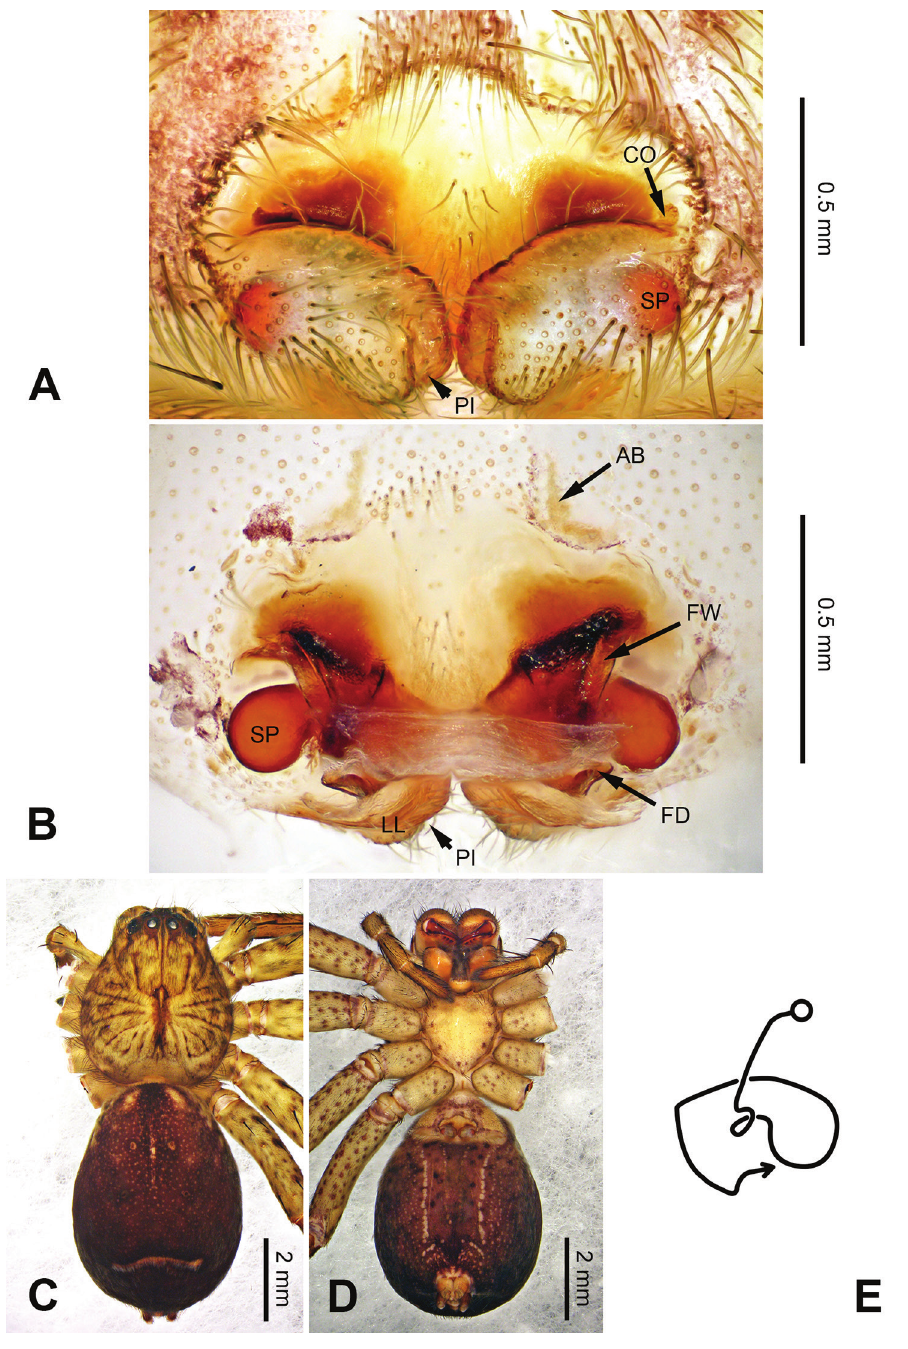
Figure 33. Pseudopoda yuanjiangensis Zhao & Li, sp. n., female holotype. A Epigyne, ventral view B Vulva, dorsal view C Habitus, dorsal view D Habitus, ventral view E Schematic course of internal duct system, dorsal